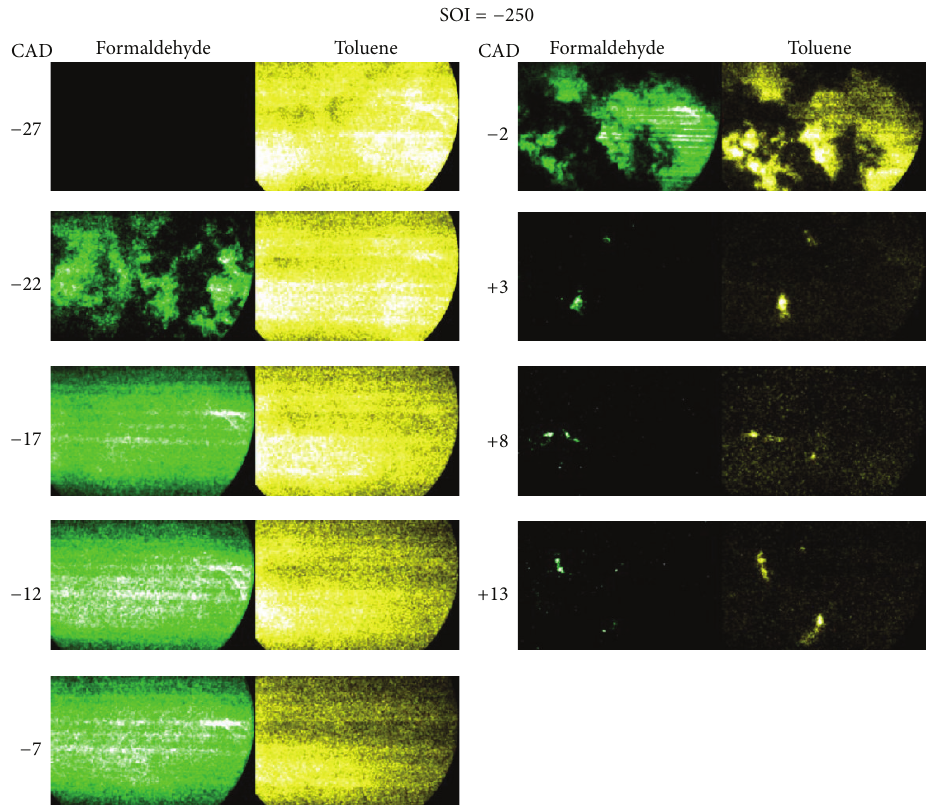
Figure 17: Simultaneous images of formaldehyde and toluene at start of injection of − 250 ∘ CA ATDC to ensure the fuel sufficient time to mix with air forming a very homogeneous mixture before ignition